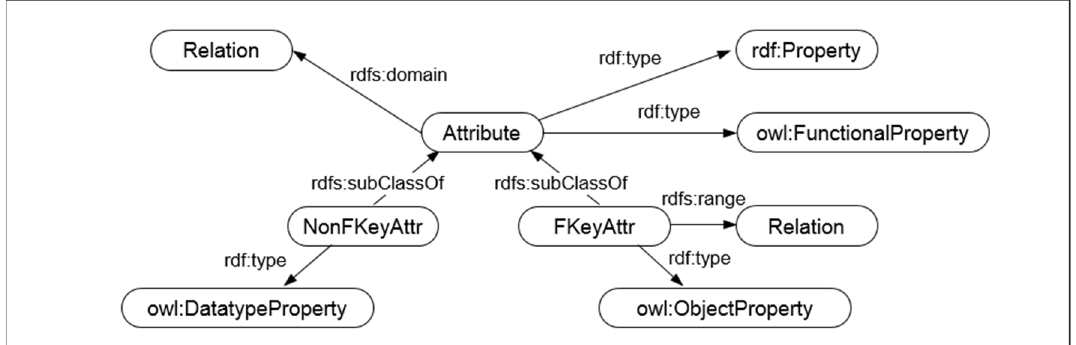
Figure 11. Set of attributes as a hierarchical structured semantic vocabulary (Rule 2).